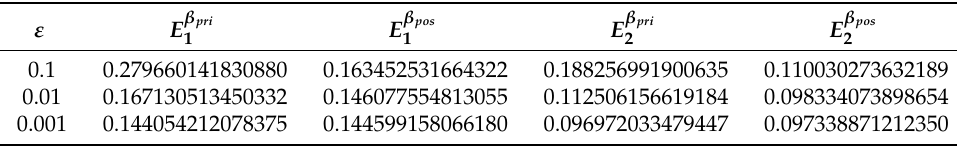
Table 1. The error estimation between the exact and regularized solutions of this example at β = 0.95 with N = 100.